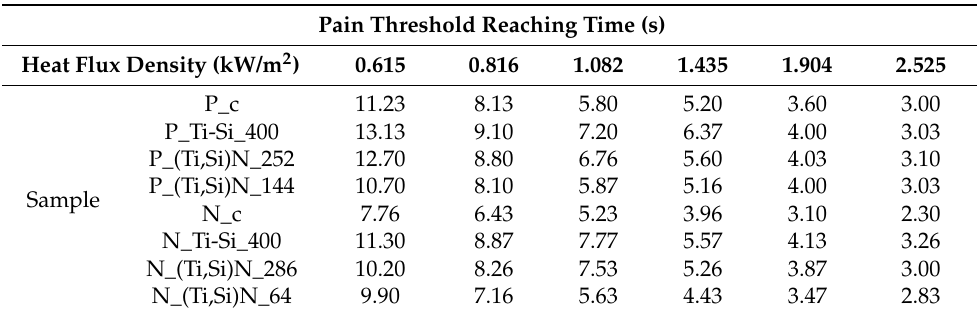
Figure 17. Summary of pain threshold reaching time for NATAN and PROTON samples in accordance to heat flux density. Table 3. Pain threshold reaching time for NATAN and PROTON samples in accordance to heat flux density.